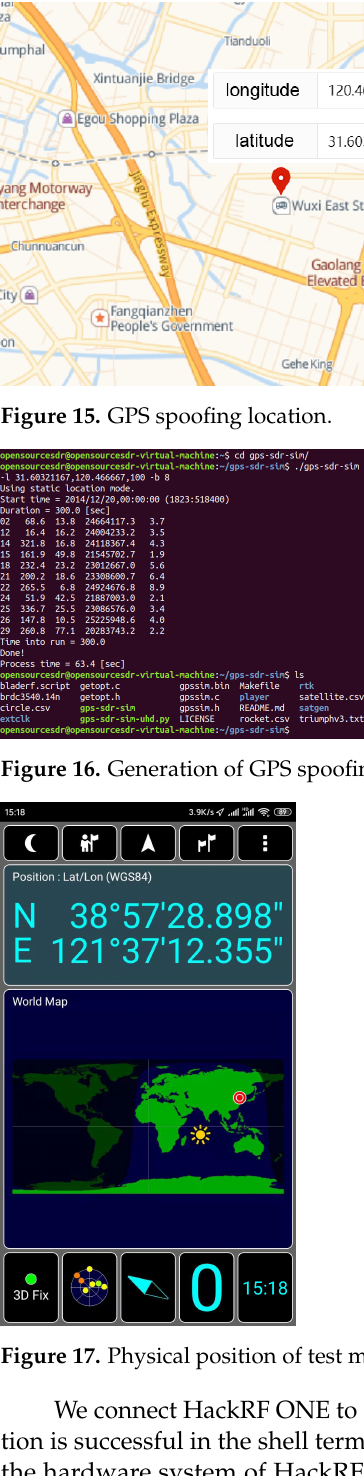
Figure 14. GPS-SDR-SIM download and compile.